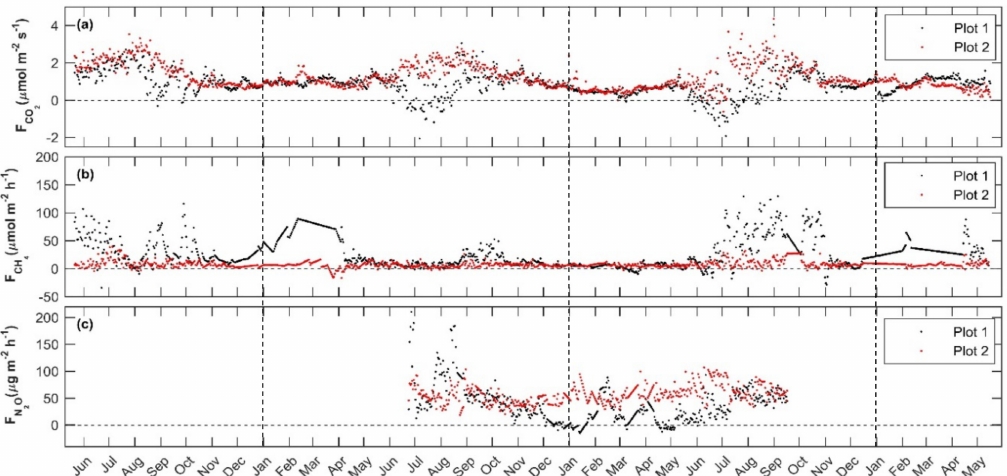
Figure 9. Daily average Greenhouse Gas (GHG) fluxes at plot 1 (black dots) and plot 2 (red dots). ( a ) CO 2 fluxes from May 2010 to May 2013. ( b ) CH 4 fluxes from May 2010 to May 2013. ( c ) N 2 O fluxes from June 2011 to September 2012. The e ff ect of gap-filling using linear interpolation can be clearly seen in, e.g., February–April 2011 (panel b) and in, e.g., January 2012 (panel c). Vertical dashed lines mark the start of a new year. Table 2. Cumulative GHG fluxes from May 2010 to May 2011 (year 1), May 2011–May 2012 (year 2) and May 2012 to May 2013 (year 3). The global warming potential factors used in the conversions for gCH 4 m − 2 and gN 2 O m − 2 were 28 and 265, respectively [91].